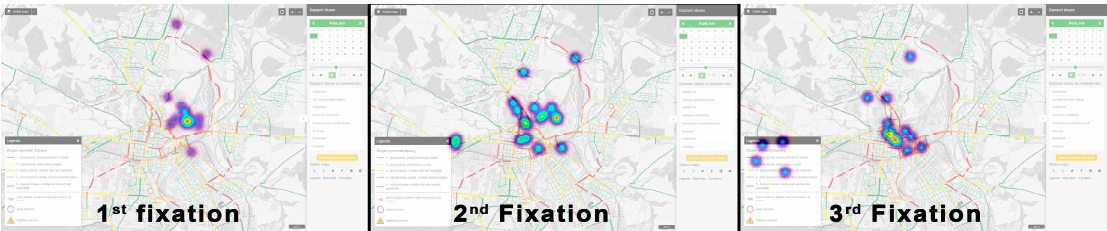
Figure 6. Attention map for stimulus 1 of the Pilsen map showing first, second, and third fixations.